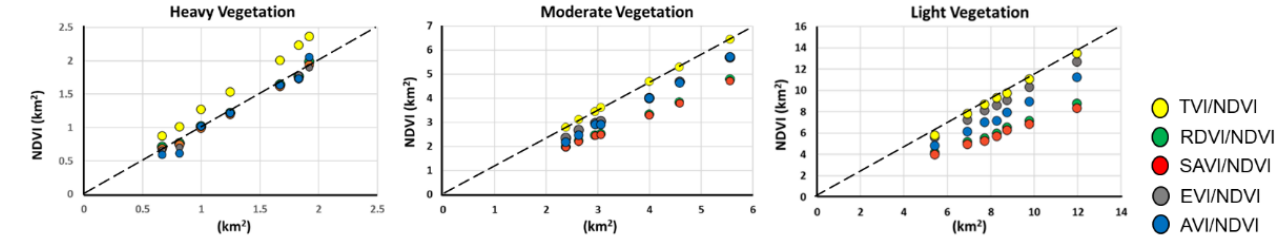
Figure 7. The correlation between the NDVI and all the used indices for the heavy, moderate, and light vegetation.